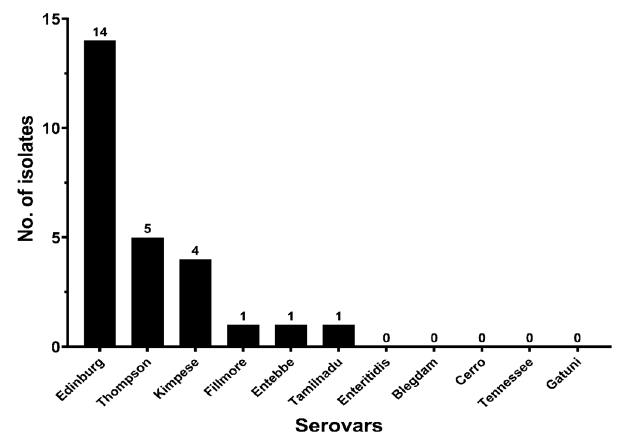
Figure 3. The distribution of ESBLs isolates among the studied serovars.